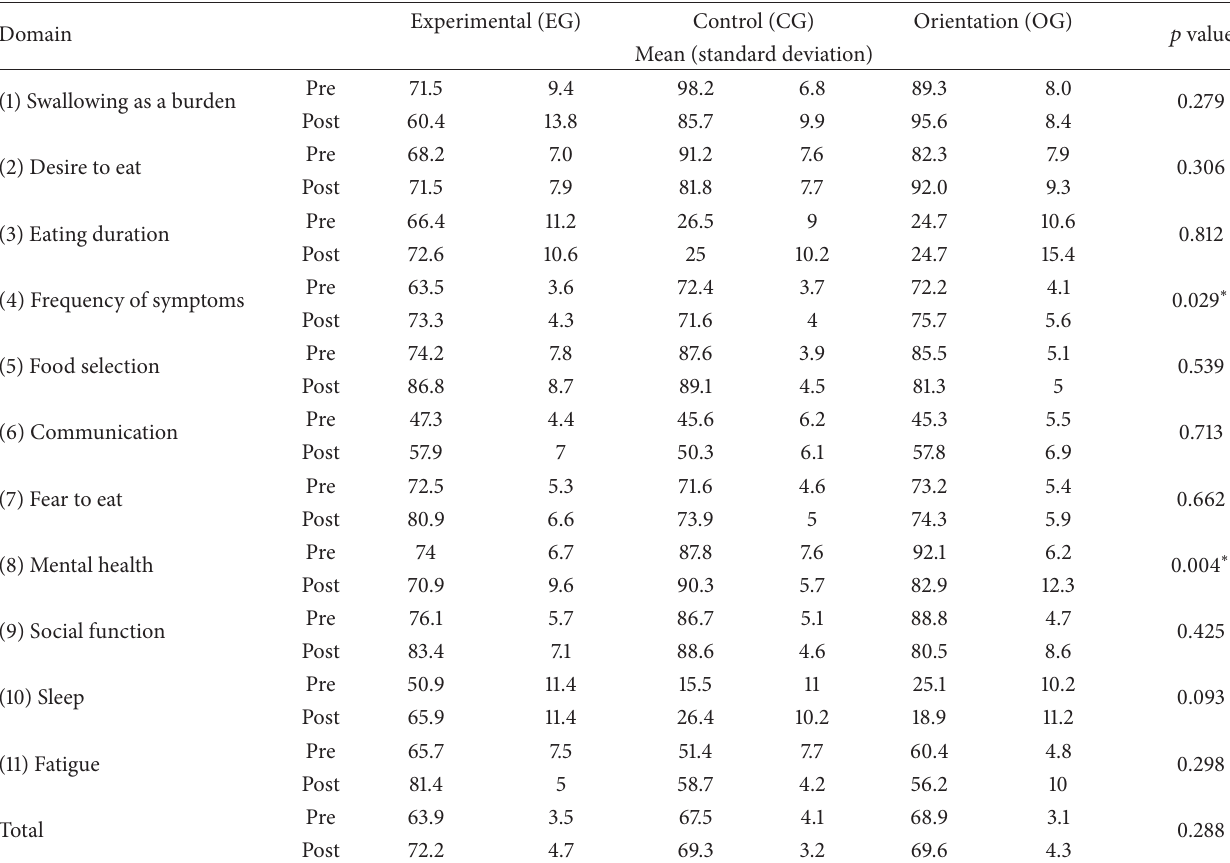
Table 3: SWALQOLL analysis before and after